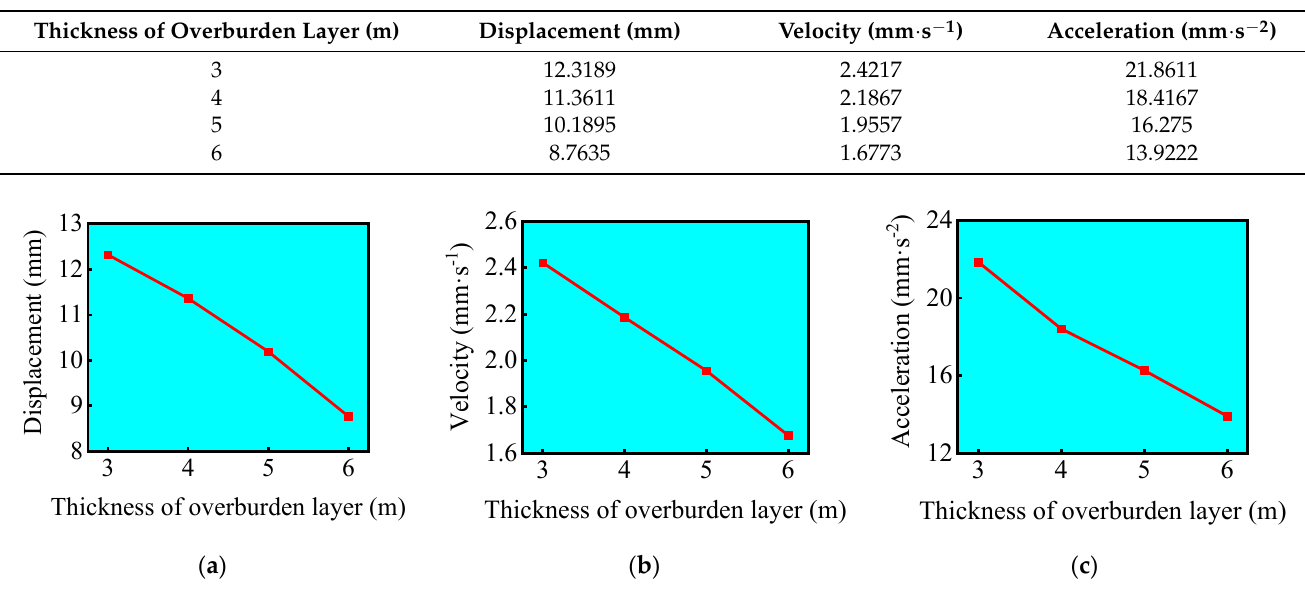
Figure 18. The law of mid − span peak value changing with thickness of overburden layer ( a ) dis- placement, ( b ) velocity, and ( c ) acceleration. placement, ( b ) velocity, and ( c )